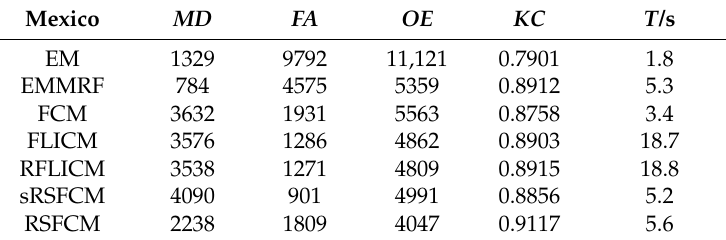
Table 2. Change detection results on Mexico dataset.